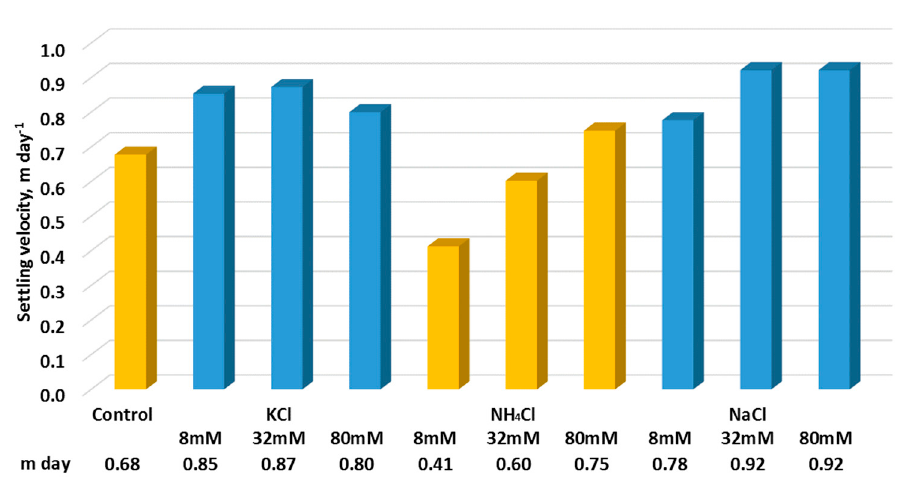
Figure 6. Settling velocity of C. vulgaris subjected to different salt concentrations of NaCl, KCl and NH 4 Cl.